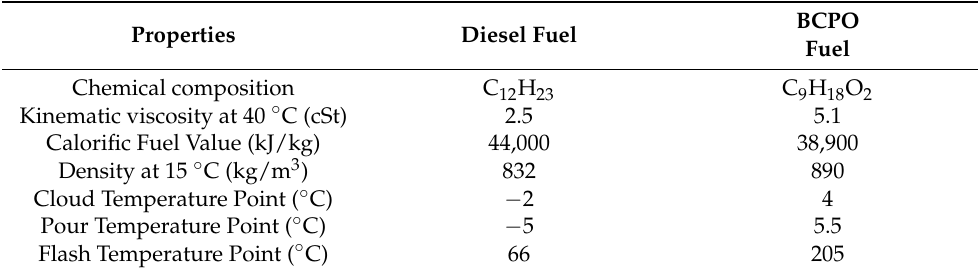
Table 1. Diesel and BCPO characteristic features.